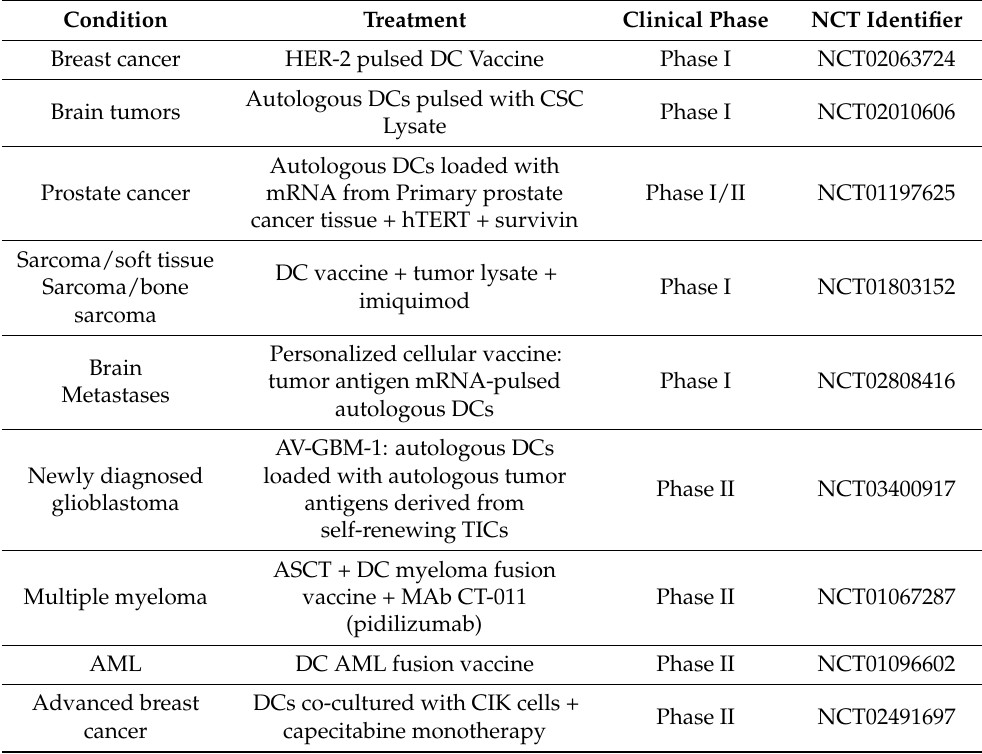
Table 1. Representative selection of the currently active clinical trials investigating dendritic cell- based cancer